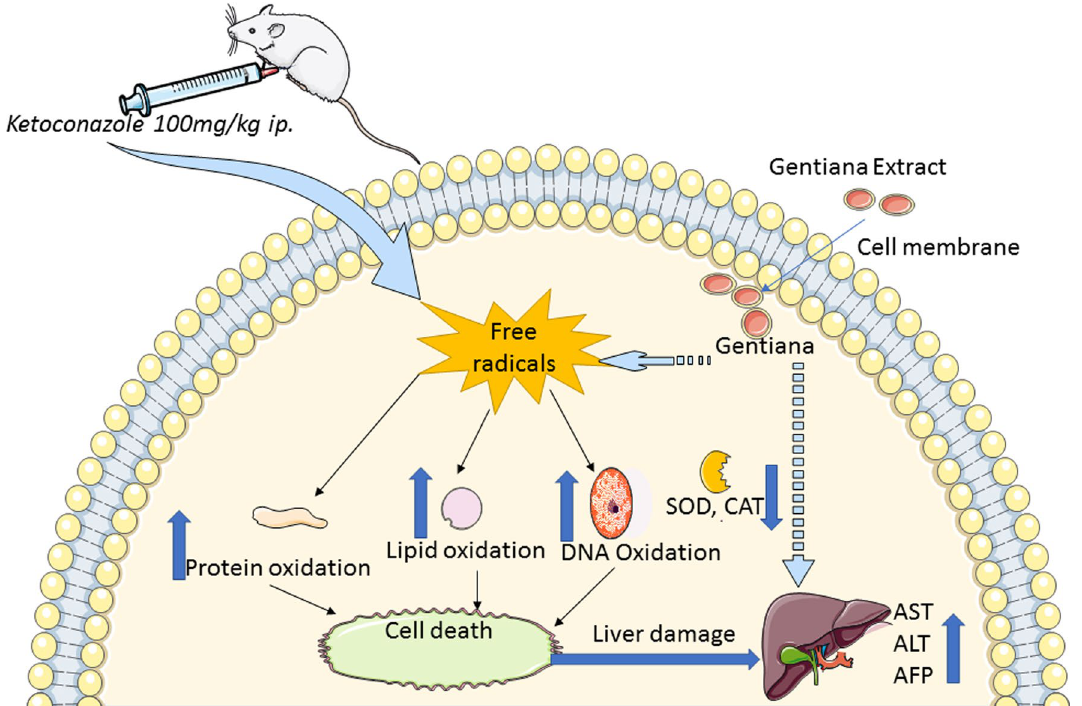
Fig. 7 The overview of cellular oxidative stress and toxicity in liver tissue of rats after ketoconazole treatment. The speculative pathway indicates the hepatotoxicity effect of ketoconazole attributed to oxidative damage to hepatic proteins, lipids, and DNA, and depletions in natural antioxidants (SOD, CAT), while Gentiana prevented the hepatotoxicity of ketoconazole via its antioxidant effects (fragmented